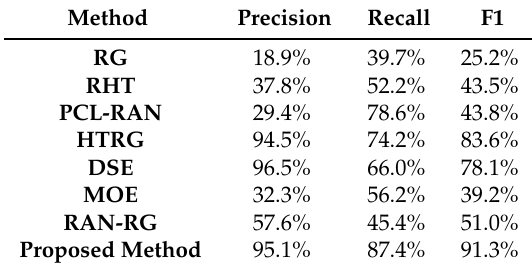
Table 5. Indicators score of plane1.